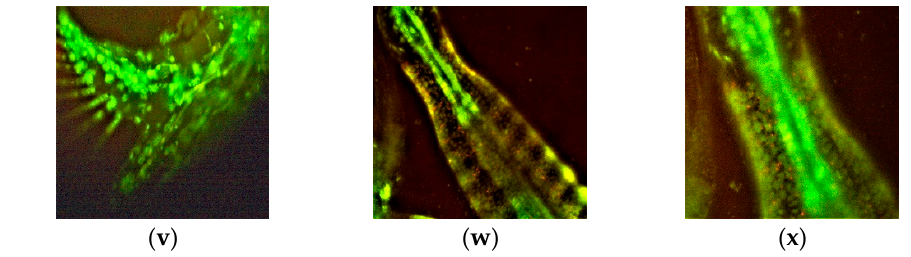
Figure 3. A. salina larvae after the exposure to F-UBE-HPMC ( a – p )—microscopic images at 100×